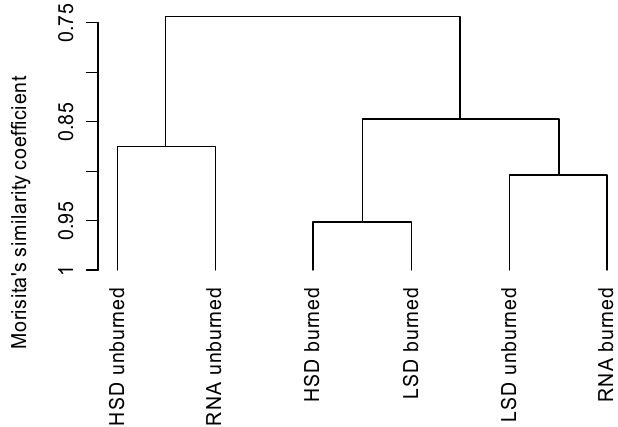
Figure 8. Dendrogram of Morisita similarity coefficients ( C assemblages from all three sampling